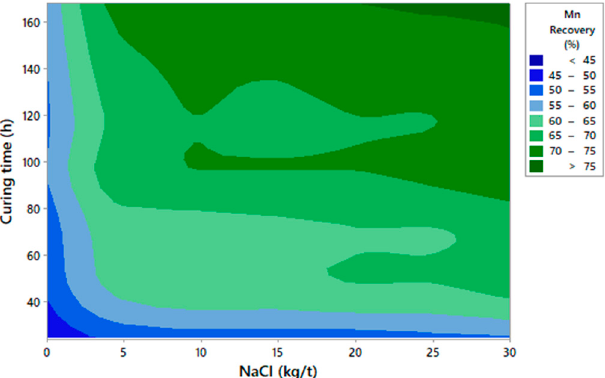
Figure 3. Contour plot of Mn recovery (%) versus NaCl concentration and curing time (h).